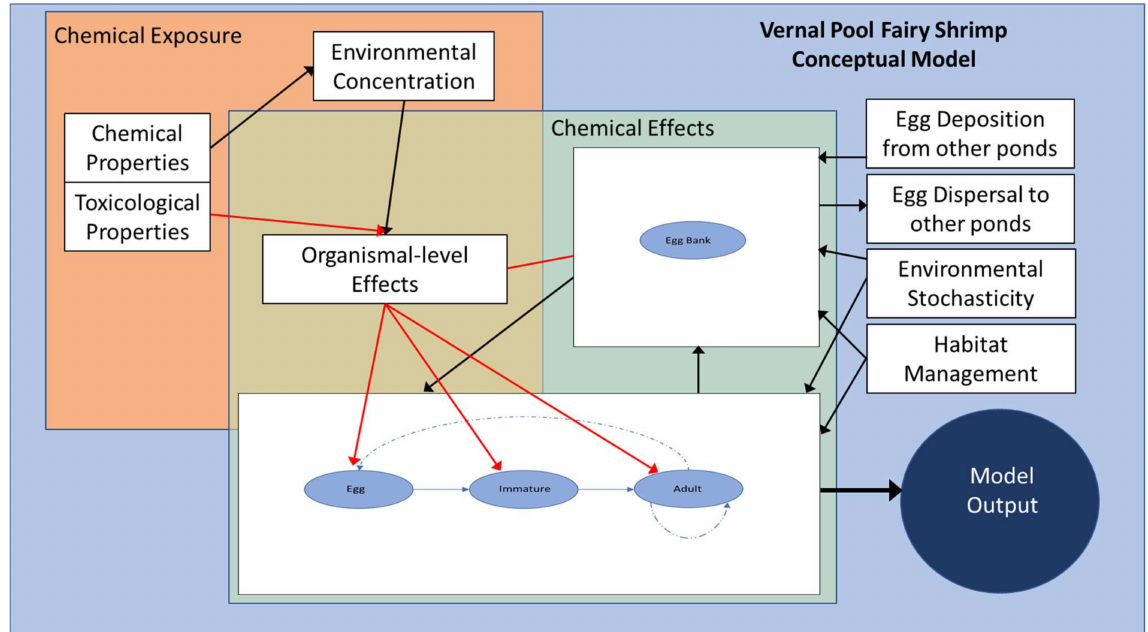
Figure 3. A conceptual model demonstrating both an illustrational and written summary of the compartments within a vernal pool fairy shrimp population model and their linkages. The egg bank comprises eggs accumulated in the substrate over a multiple year period. The red arrows depict adverse pathways associated with a pesticide, and all other connections are represented by black